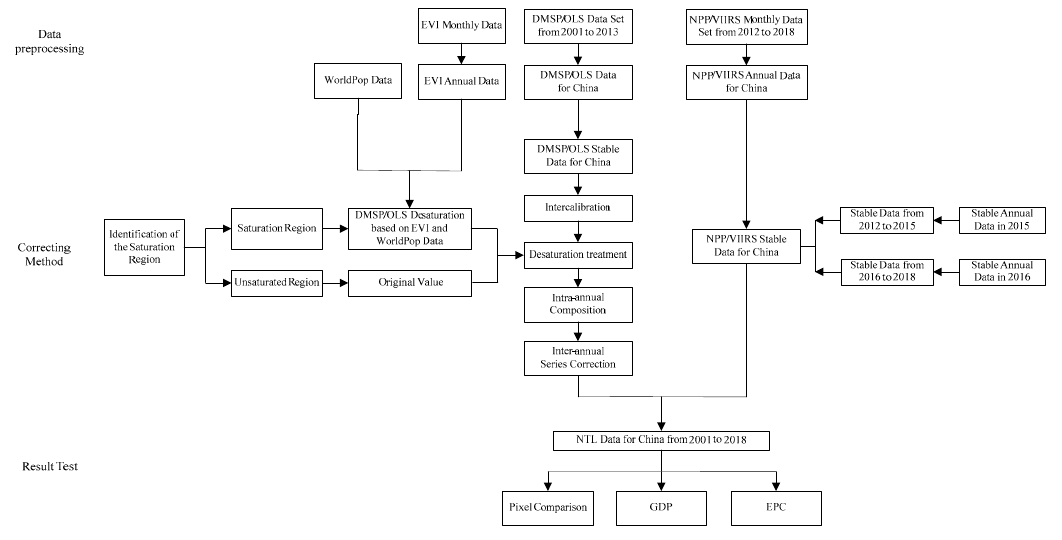
Figure 1. Technology roadmap.